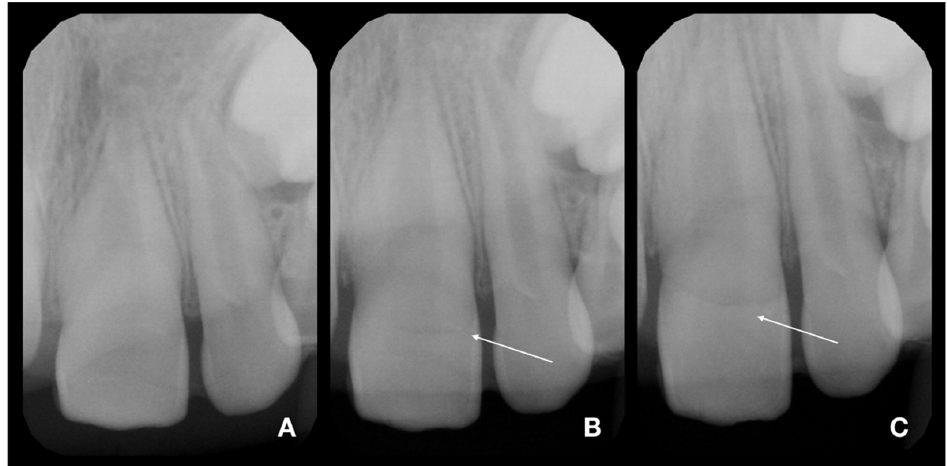
Figure 2. Diagnostic X-rays of teeth 21 and 22 in three different angulations [21]. ( A )—foreshortened X-ray (increased angulation of central beam to the direction used in ordinary occlusal exposure). The fracture line is almost not visible. ( B )—distortion-free X-ray (angulation used in ordinary occlusal exposures). The fracture line started to be pronounced; see arrow. ( C )—elongated X-ray (decreased angulation of central beam to the direction used in ordinary occlusal exposure). The fracture line is clearly visible; see arrow.